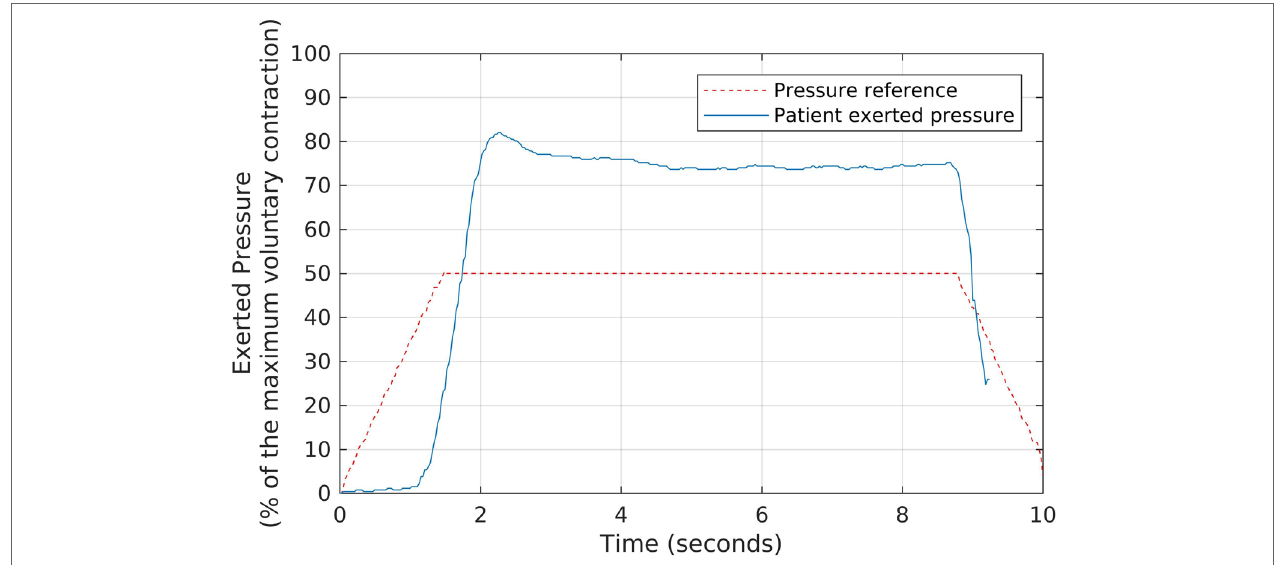
FIgURe 5 | The slow, sustained pressure waveform used as the reference for each volunteer during the second stage of the biofeedback sessions, and the corresponding pressures exerted by a patient. We oriented each participant to try and keep a sustained pressure level above the reference waveform, by exerting pressure over the anal probe, while watching the generated signals in real